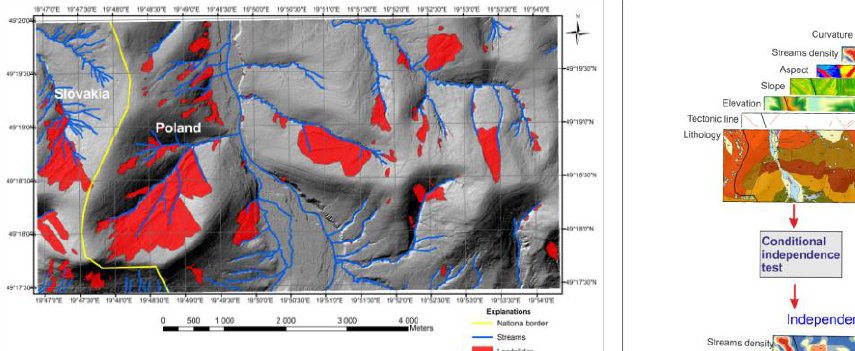
Fig.3. Landslides of the study area.